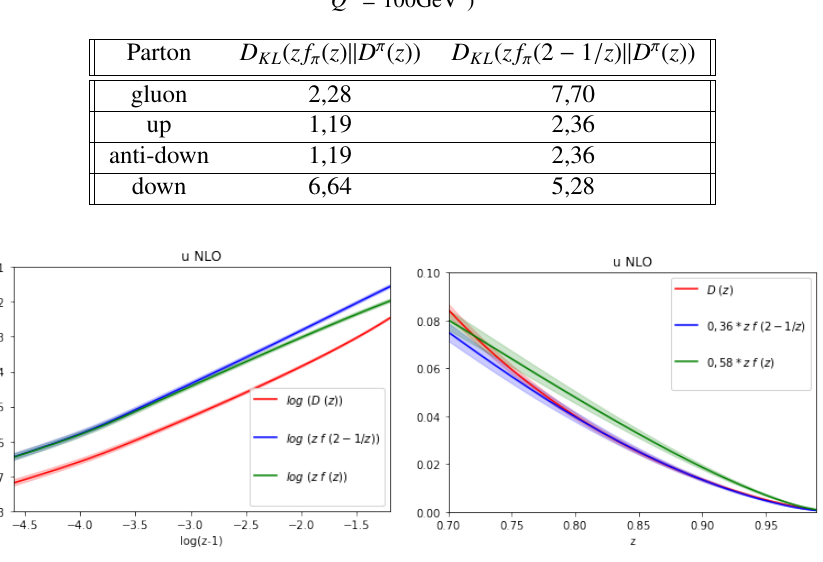
Figure 6. The functions entering the Barone-Drago-Ma relation in a logarithmic plot showing near parallelism (left) and the nearly equal rescaled functions in a linear plot